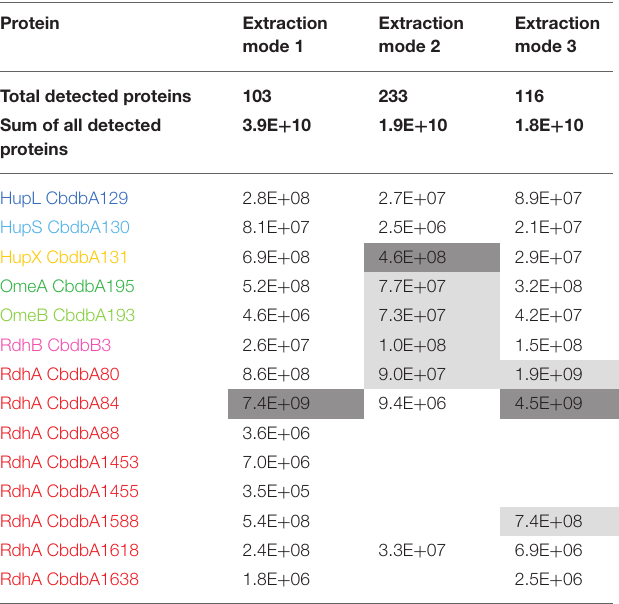
TABLE 2 | Absolute abundance values for all suspected OHR complex subunits as a sum of the determined mass spectrometric area counts in all slices.